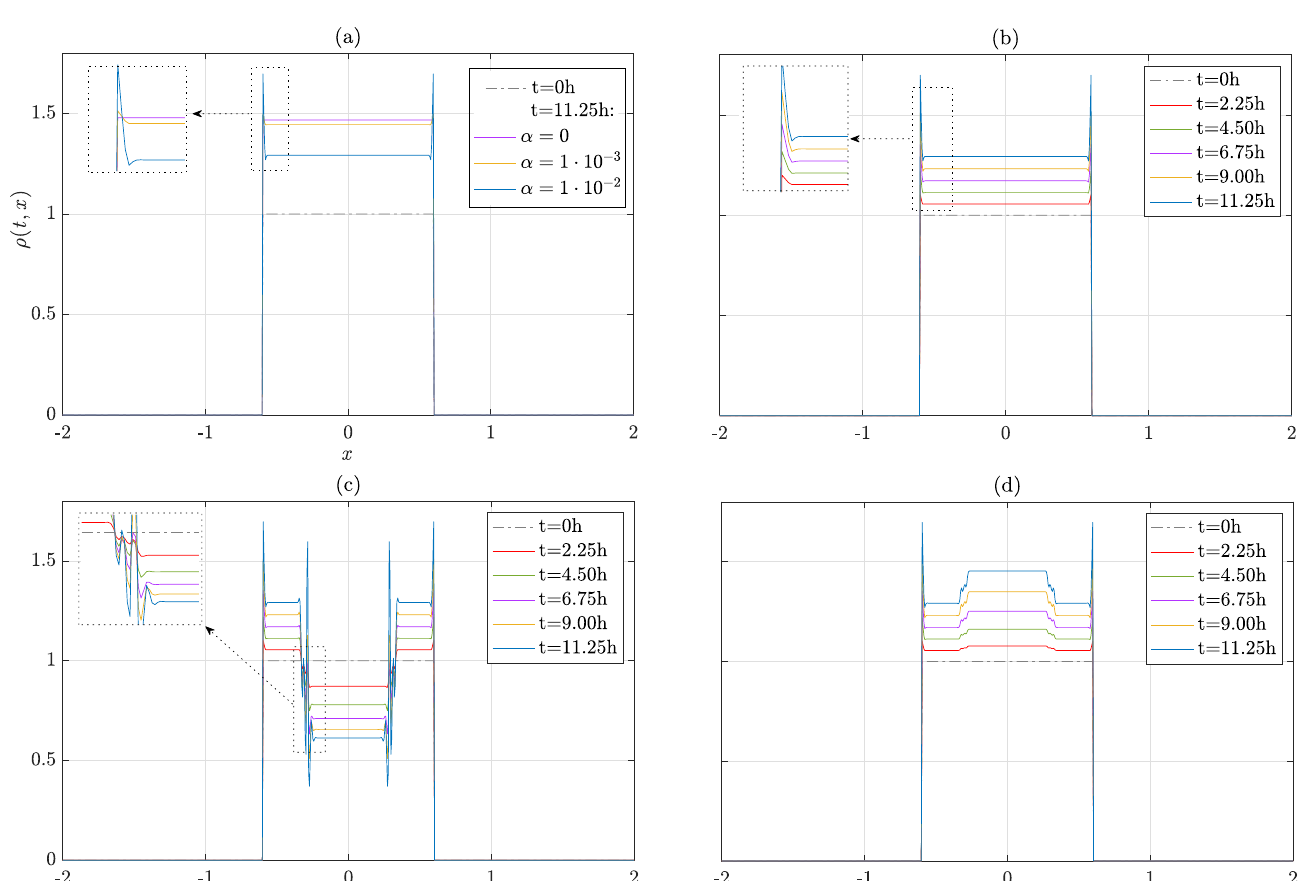
Figure 3. Growth and internal pressure dependence without migration. ( a ) Cluster of cells growing slower than its surroundings ( α = 1 · 10 − 1 and α = 1 · 10 − 2 mm 2 cell − 1 h − 1 in the core and the inner region, respectively). ( b ) Cluster of cells growing faster than its surroundings ( α = 1 · 10 − 3 and α = 1 · 10 − 2 mm 2 cell − 1 h − 1 in the core and the inner region, respectively). For the four cases, proliferation rate is assumed constant, β = 3.45 · 10 − 2 h − 1 . ( c ) Cluster of cells growing slower than its surroundings ( α = 1 · 10 − 1 and α = 1 · 10 − 2 mm 2 cell − 1 h − 1 in the core and the inner region, respectively). ( d ) Cluster of cells growing faster than its surroundings ( α = 1 · 10 − 3 and α = 1 · 10 − 2 mm 2 cell − 1 h − 1 in the core and the inner region, respectively). For the four cases, proliferation rate is assumed constant, β = 3.45 · 10 − 2 h − 1 and the figures have the same axis label. The results correspond to a tumor with a radius of 1